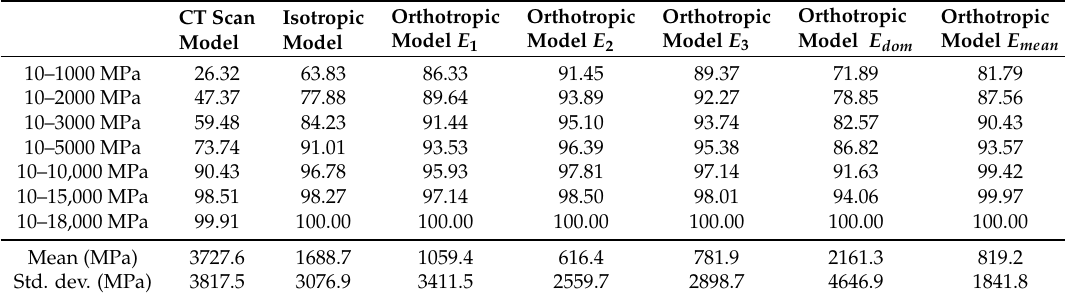
Figure 3. Distributions of Young’s modulus (MPa) for the isotropic model ( a – c ), dominant Young’s modulus ( d – f ) and mean Young’s modulus ( g – i ) for the orthotropic model. Table 2. Cumulative distribution (%) of elastic moduli of the three continuum models: CT scan derived, isotropic and